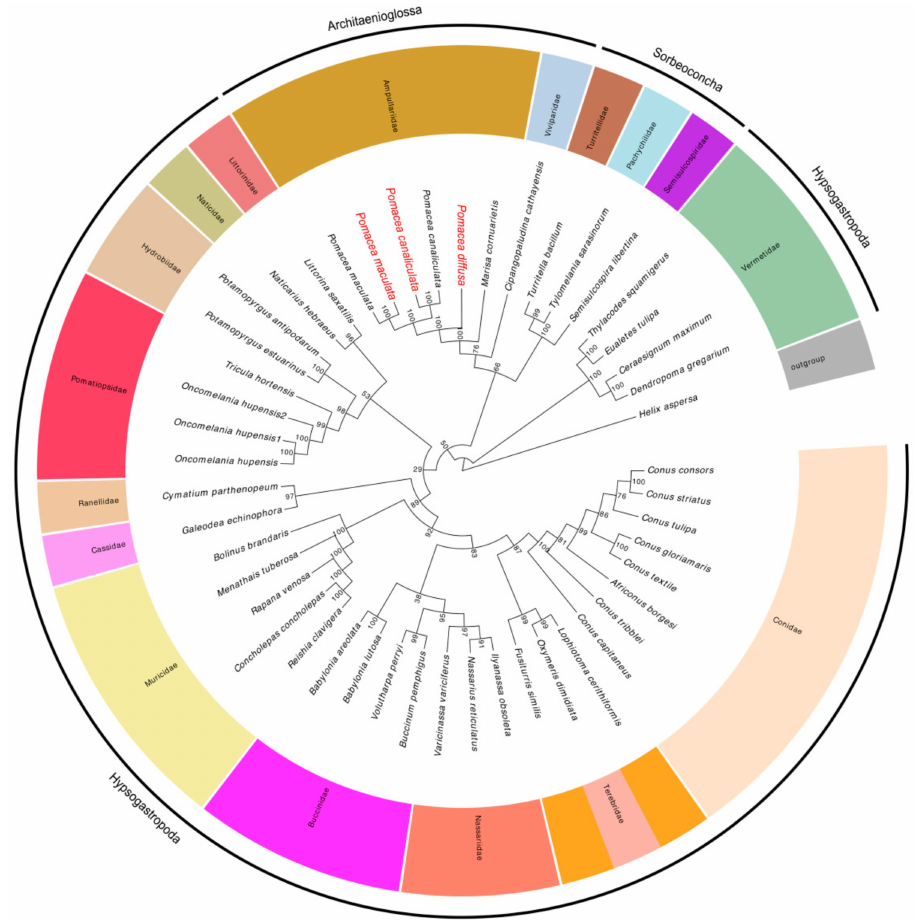
Figure 8. Bayesian inference tree inferred from the amino acid sequences of 13 PCGs of 47 species of Caenogastropoda. Helix aspersa , NC_021747, was used as the outgroup. The numbers at the nodes represent the Bayesian posterior probabilities. Species in red indicate sequences generated in this